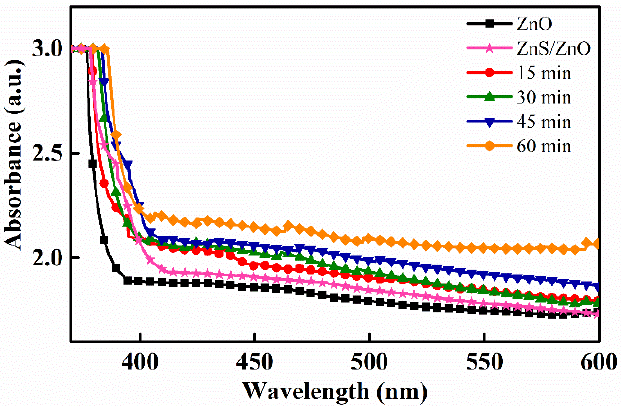
Figure 6. Absorption spectra of Ag 2 S/ZnS/ZnO nanocomposites with various immersion time. A photodetector was fabricated with In electrodes to investigate the optoelectrical properties of Ag 2 S/ZnS/ZnO nanocomposites. The I-V characteristics of photodetectors with various immersion time under 365 nm UV LED are shown in Figure 7a–d. It can be observed that photodetectors have a photoresponse under UV illumination. The reverse